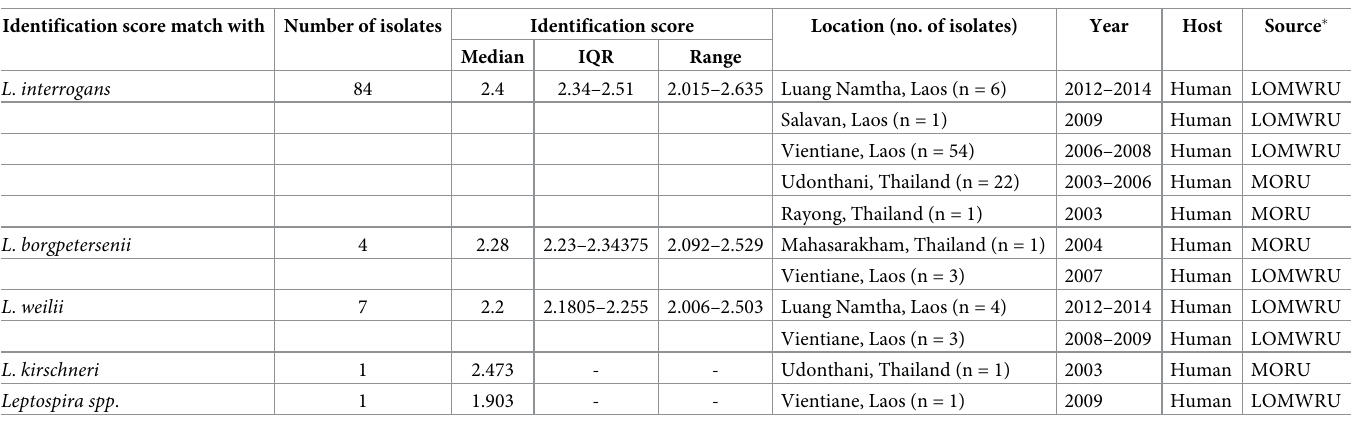
Table 4. Identification score of blinded 97 Leptospira clinical